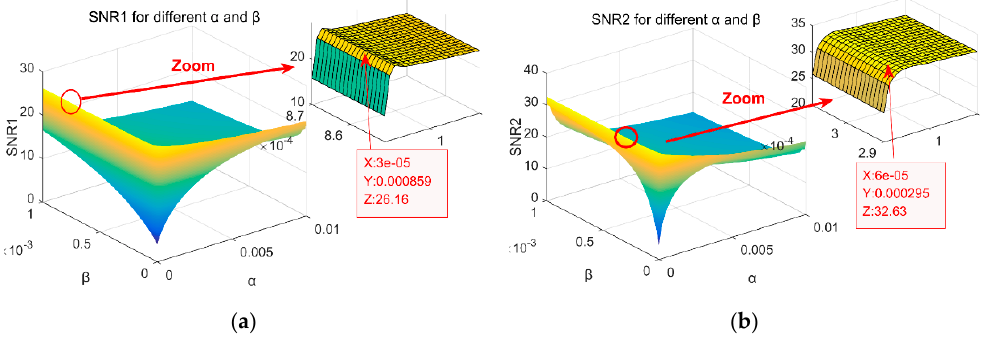
Figure 7. I nstantaneous frequency( IF)s1 and IFs2 optimization process(( a ). SNR1 for different α Figure 7. Instantaneous frequency(IF)s1 and IFs2 optimization process(( a ). SNR1 for di ff erent α and β ; and β ;( b ). SNR2 for different α and β ). ( b ). SNR2 for di ff erent α and β